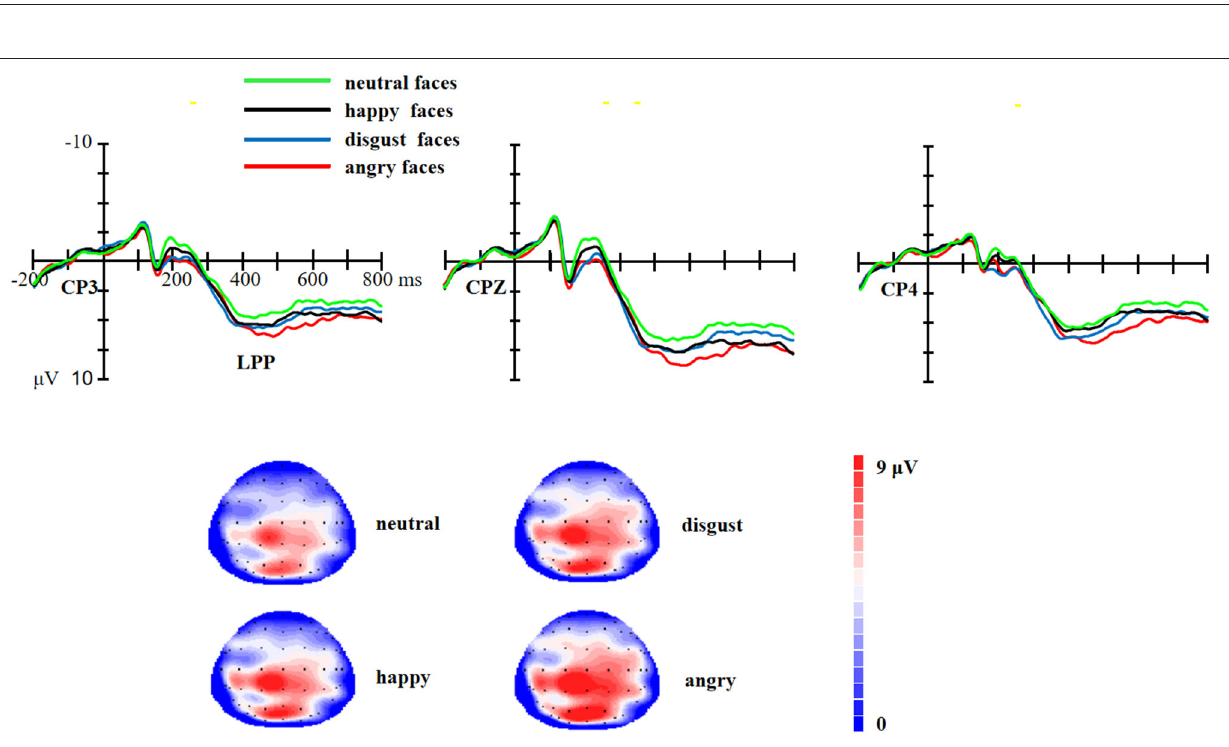
Frontiers in Psychology |